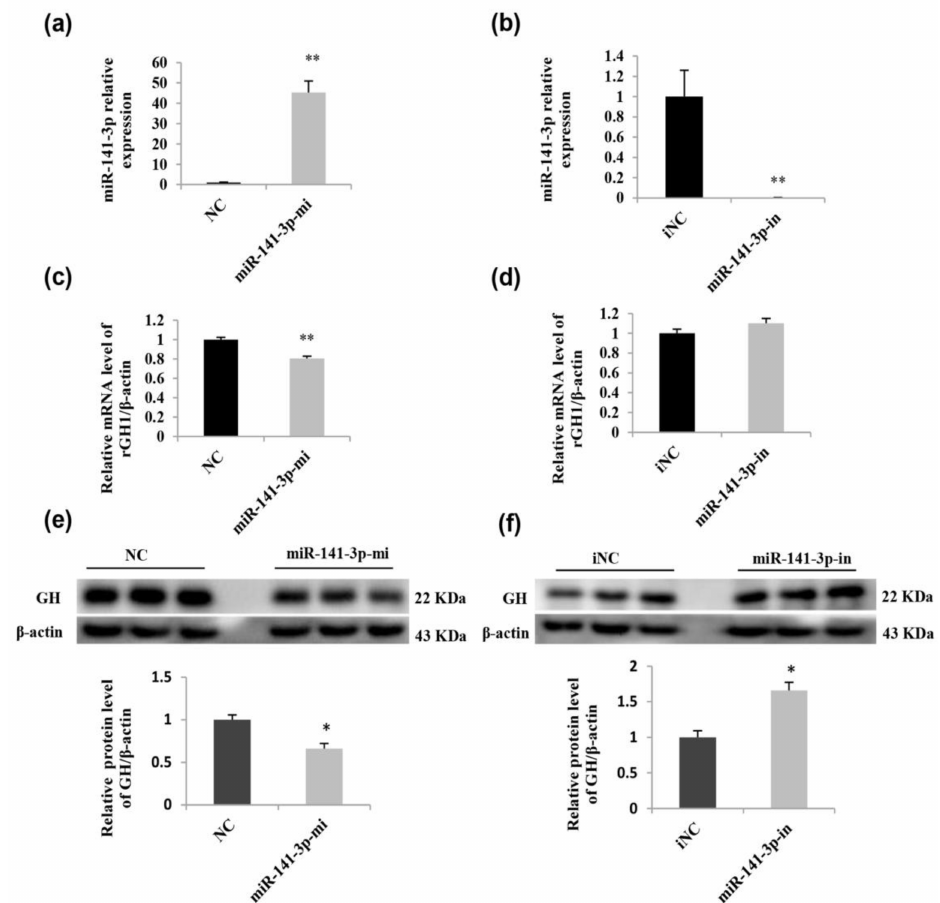
Figure 7. miR-141-3p negatively regulates growth hormone (GH) mRNA and protein expression. GH3 cells were separately transfected with 100 pM miR-141-3p mimic and miR-141-3p inhibitor. Forty-eight hours later, GH3 cells were collected. ( a , b ) Analysis of miR-141-3p levels by qRT-PCR. ( c , d ) Analysis of GH1 mRNA levels by qRT-PCR. ( e , f ) Analysis of GH protein levels by Western blot and quantitative analysis of the Western blot results. Results are presented as the means ± SEM ( n = 3). *, p < 0.05, **, p < 0.01, ( t test). iNC, inhibitor negative